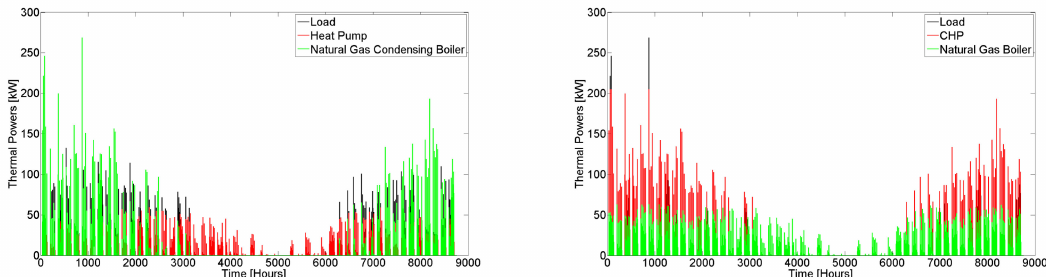
Figure 12. Examples of heating system’s operation obtained using the proposed